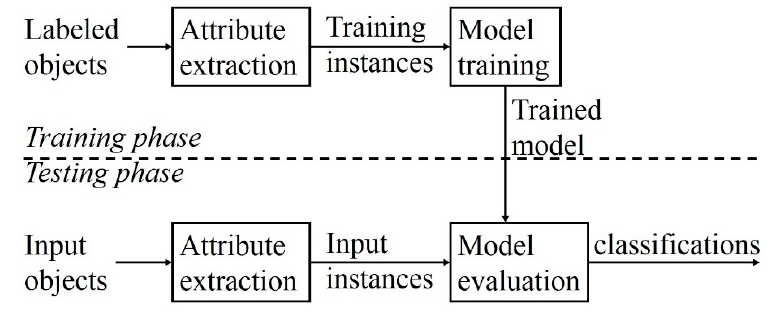
Figure 1. Functionality of classification.